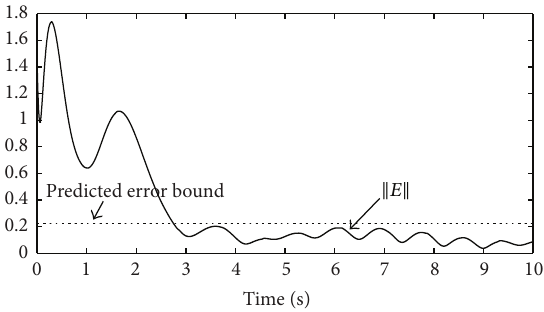
Figure 8: The error bound with unmatched